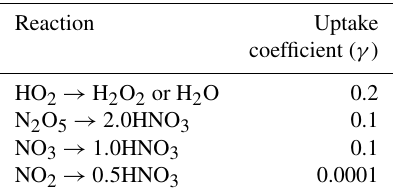
Table 1. Heterogeneous reactive uptake coefficients for several re- actions in